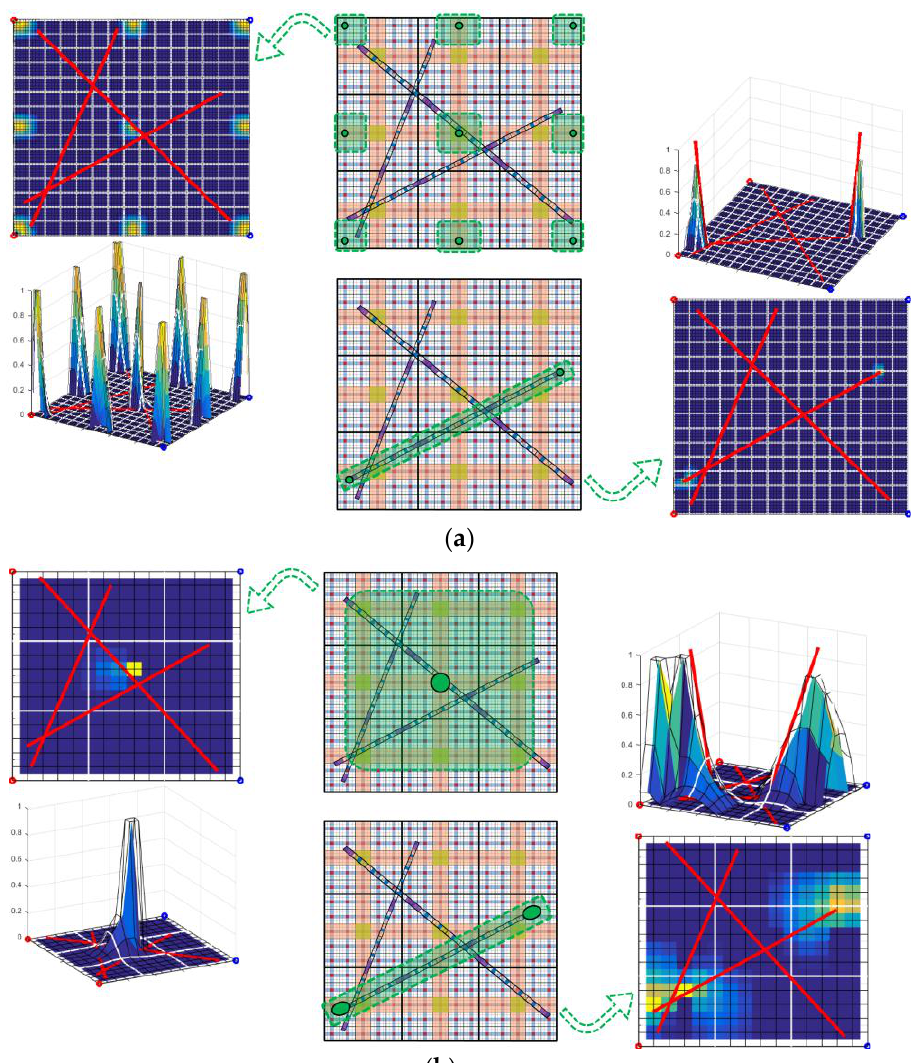
Figure 2. Workflow for the ADM strategy.